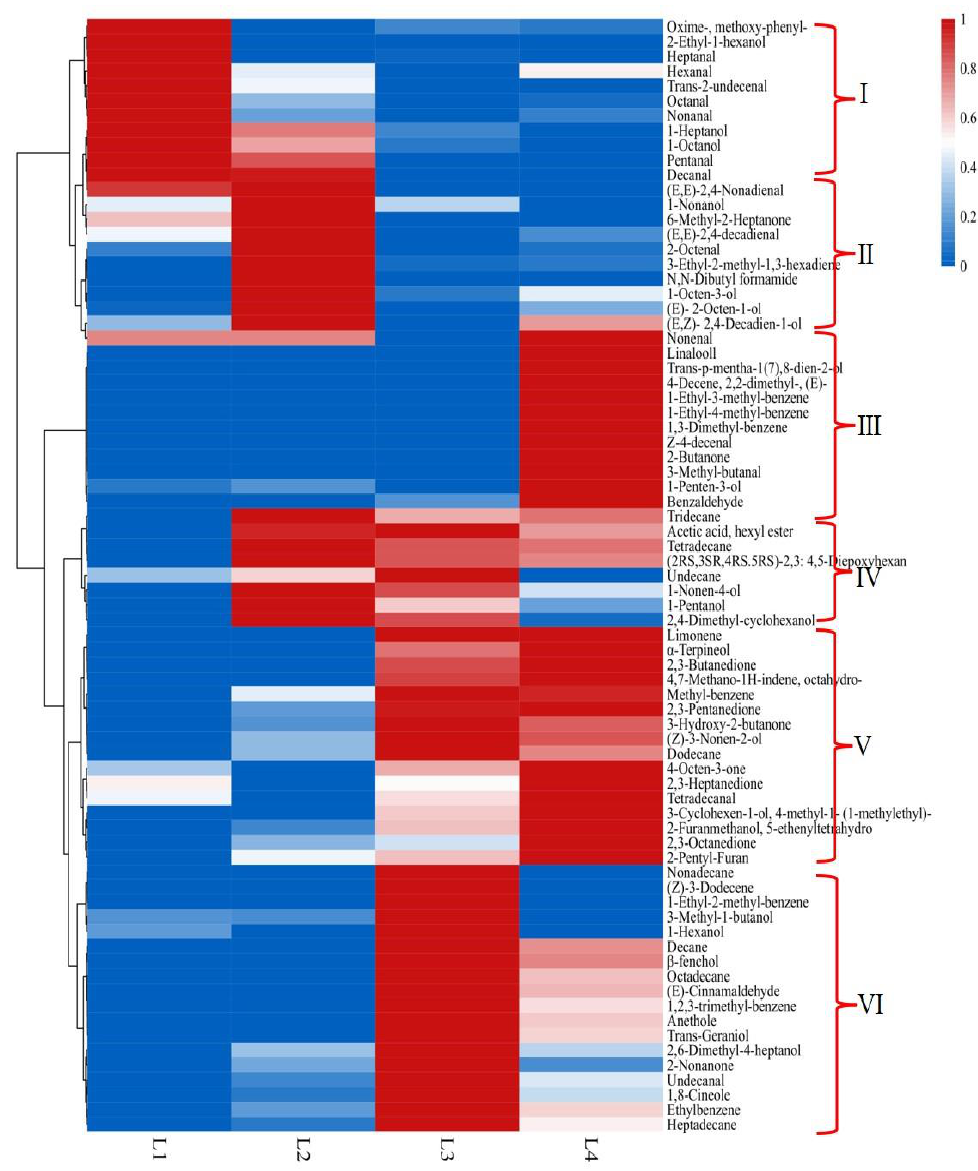
Figure 3. Analysis of heat map of volatile compounds during different processing stages.